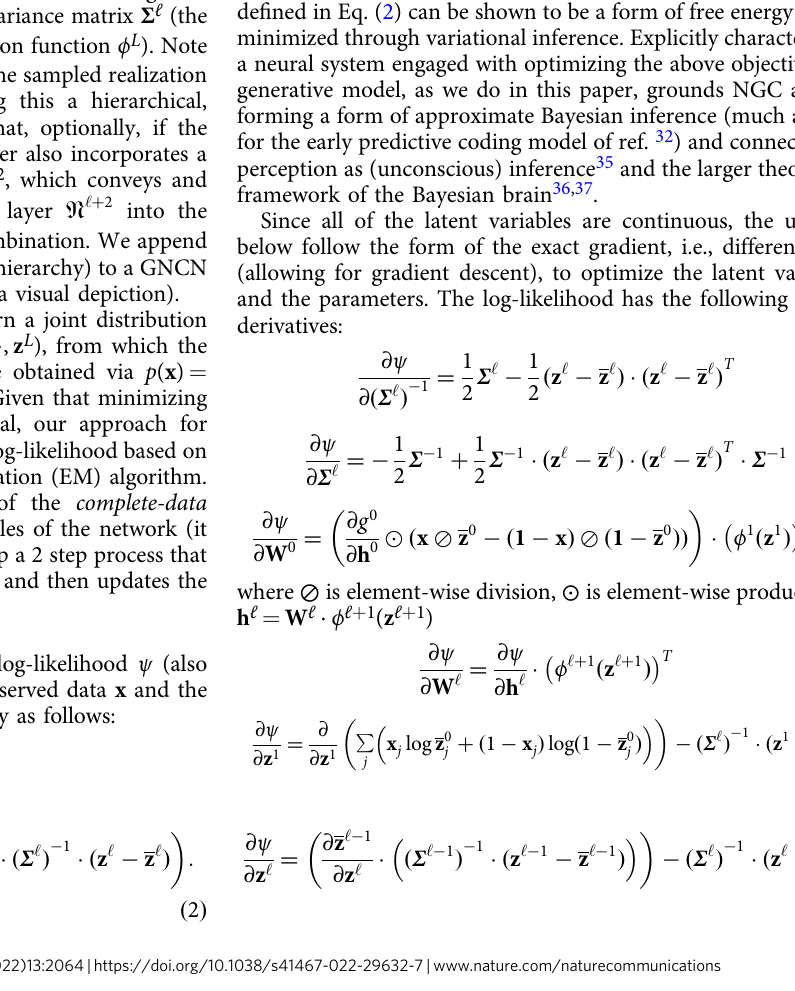
Fig. 2 Neural generative coding computation and circuitry. a The two key computation steps taken by an entire NGC network (a GNCN-t2-L Σ ) when processing an input ( z 0 = x ): (1) prediction and laterally-weighted error computation, (2) error-correction of neural states. In this diagram, we depict a toy network with 3 layers of 2 state neurons (gray circles), i.e., z 2 ¼ ð½ z 2 Two of these layers are linked to error neurons (orange diamonds), i.e., e 1 ¼ ð½ e 1 propagated throughout the system. The bottom layer z 0 receives sensory input, i.e., an image. b The basic neural computational unit that an NGC model is composed of, consisting of a single state neuron z ‘ i and an error neuron e ‘ i at layer ℓ . In the circuit, observe that a state neuron not only receives messages from error neurons (carried by E ℓ − 1 synapses) but also a self-excitation signal and inhibition signals from laterally connected neurons (via V ℓ synapses). The error neuron receives a gain signal (via ð Σ ‘ Þ (cid:5) 1 synapses) from laterally connected error neurons. Note that fi lled diamonds indicate inhibitory signals, non- fi lled circles indicate excitatory signals, and empty squares indicate multiplicative signals. c The different GNCN architectures (under the NGC framework) experimented with in this study. Solid black arrow represents generative weights, dashed black arrow represents error weights, and dashed light pink arrow represents a temporary (virtual) backwards error pathway that is a function of the generative weights, i.e., the transpose of the error weights (the horizontal solid pink arrow indicates which forward weights are used to create the backward path